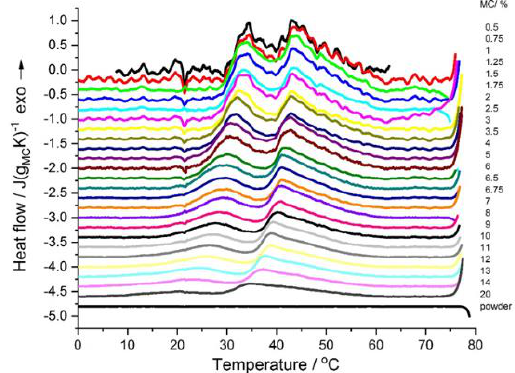
Figure 2. DSC cooling curves of the MC solutions with various concentrations (indicated) normalized to the MC weight. Curves subtracted using polynomial. For comparison, the curves are shifted in the y-axis.